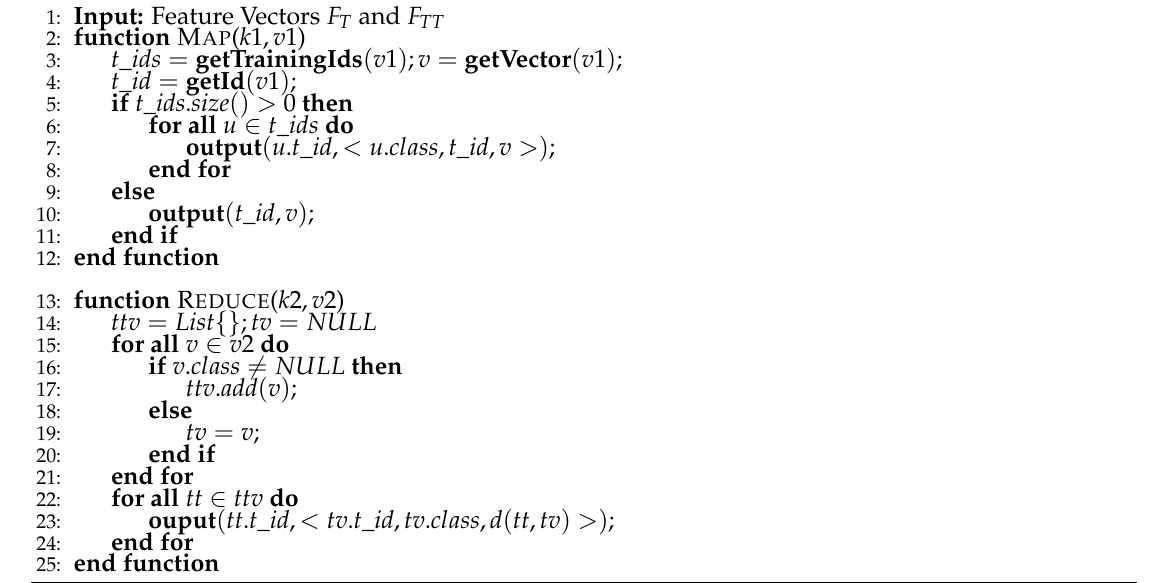
Algorithm 3: MapReduce Job 3